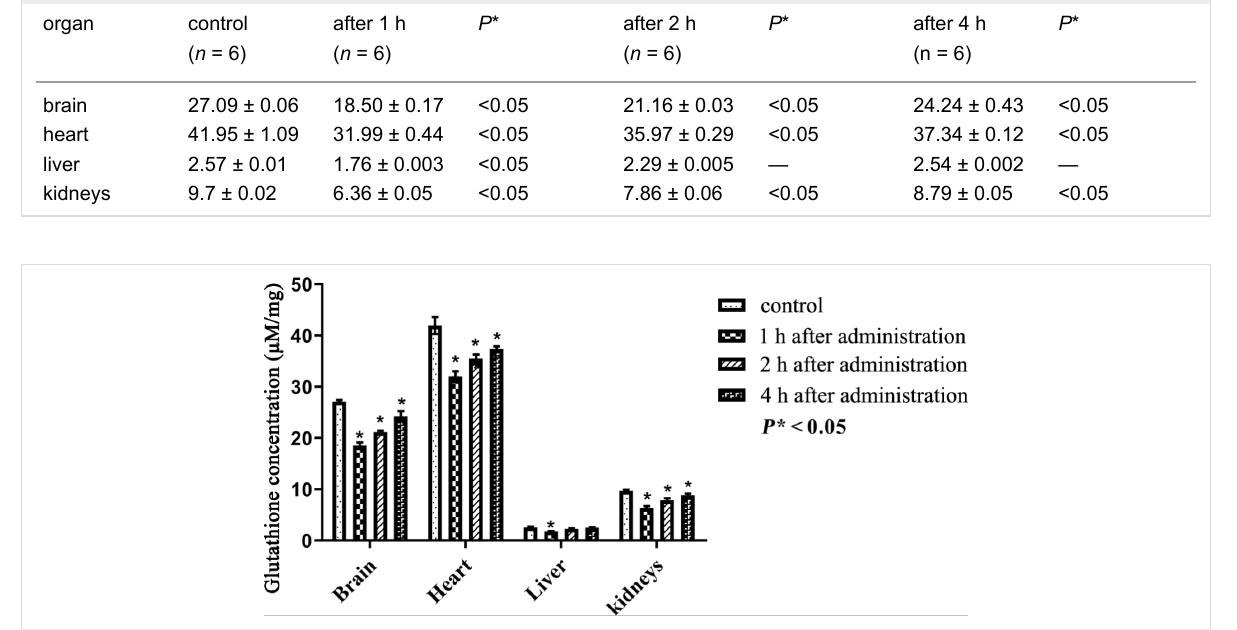
Figure 9: Concentration of reduced glutathione after intraperitoneal administration of PEG-nGO, error bars: one standard deviation.